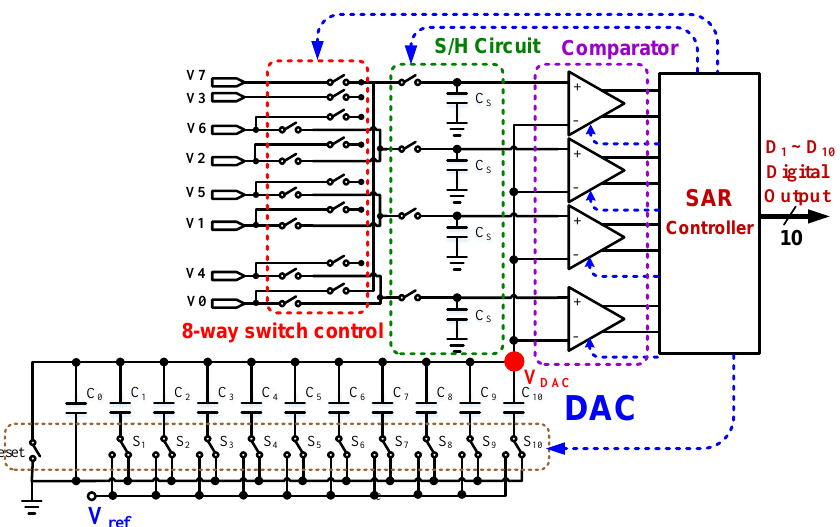
Figure 2. Schematic of the proposed SAR ADC with multiple inputs for BLDC motor drive.